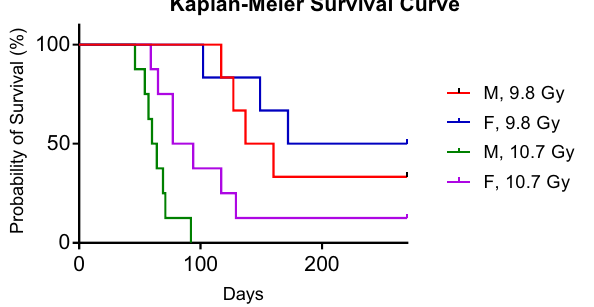
Figure 1. Kaplan–Meier survival curve for the NHPs involved in this 270-day study. High doses had lower survival than low doses and males had a worse prognosis than